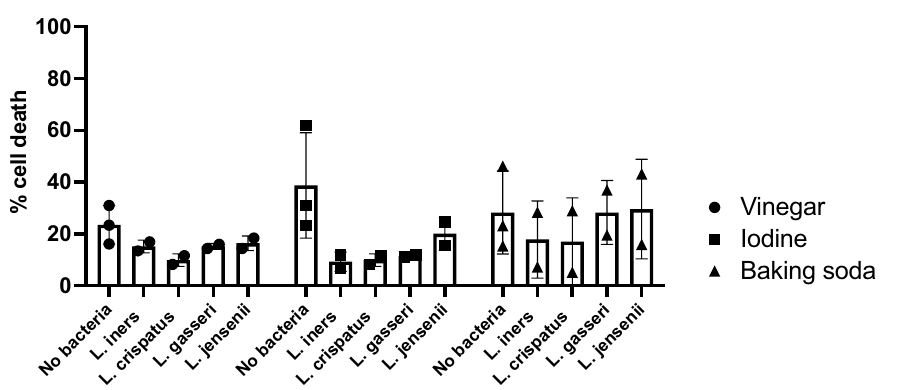
Figure 4. Impact of bacteria on vaginal epithelial cell death with douching exposure. An immortalized vaginal epithelial cell line was cultured with a 25% solution of douching product diluted in the cell culture medium for 1 h, followed by replacement with a suspension of L. crispatus or L. iners (OD 0.1) in cell culture media for 23 h. Cell death was measured with an LDH assay and values compared by ANOVA. Results are presented as mean ± SD from at least two separate